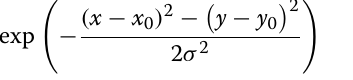
Table 1 Source scenario for the 1611 earthquake